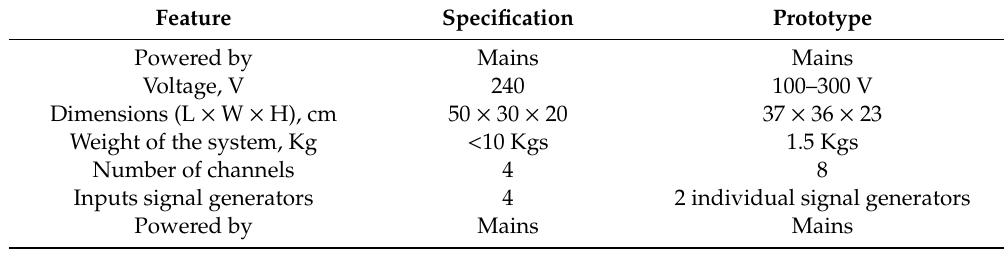
Table 4. Final hardware system requirements and features.